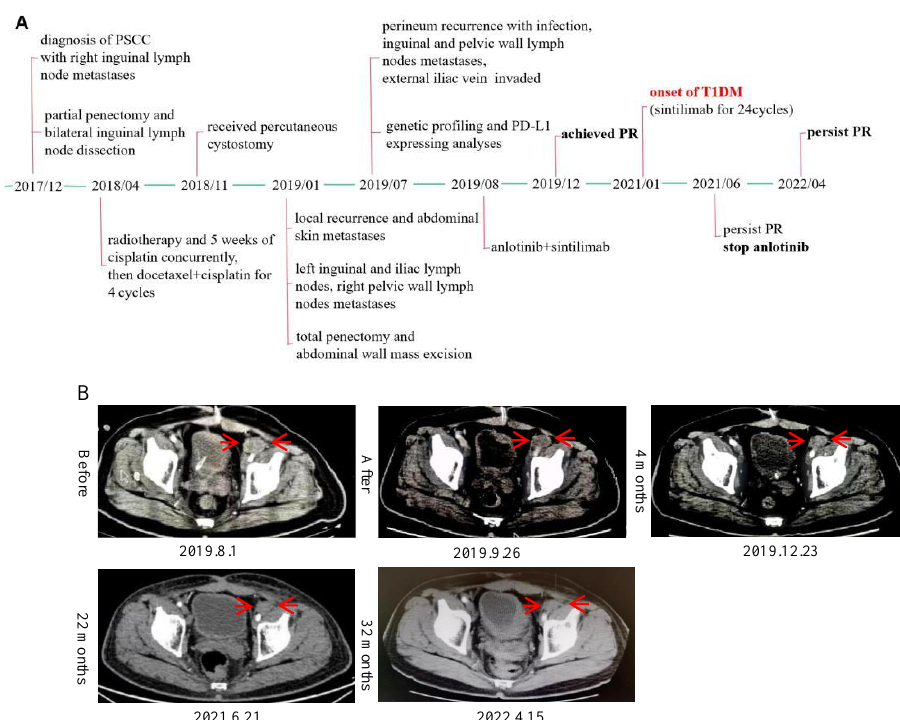
Figure 2. ( A ) Timeline of the patient’s therapy and the effects of therapy. Imaging showing metastasis of pelvic lymph nodes. ( B ) Contrast-enhanced abdominal computed tomography assessments of pelvic wall tumor nodule during each period. Red arrows indicate the tumors.